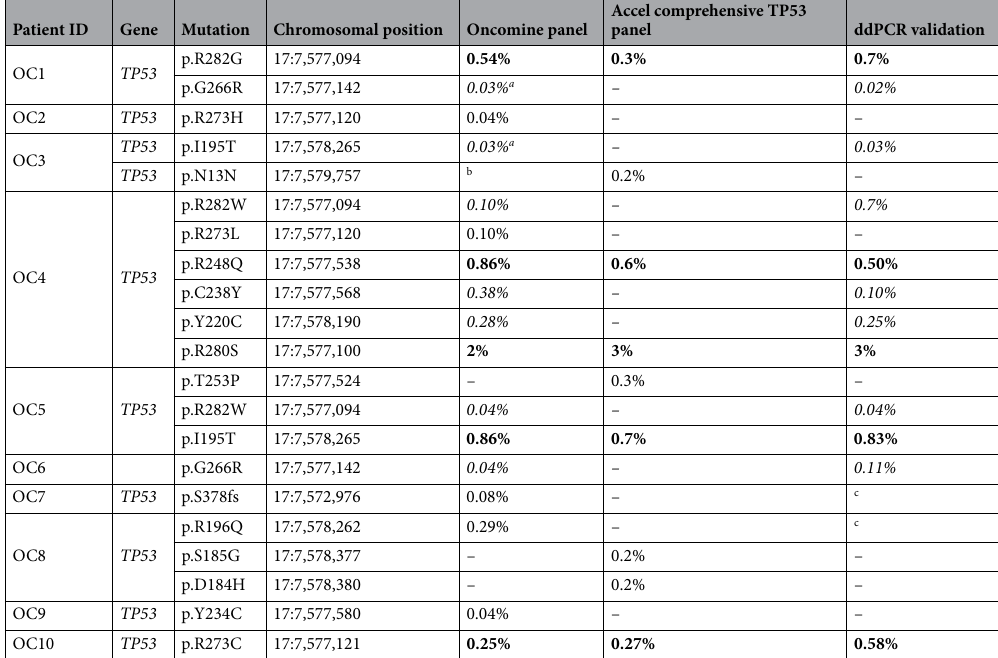
Table 1. Somatic mutations identified in ctDNA using the ONCOMINE and ACCEL NGS panels and validated by ddPCR. Bold denotes concordant variants identified using the Accel and Oncomine in cfDNA that were confirmed by ddPCR. Italics denotes variants found in Oncomine or Accell that are confirmed via orthogonal validation using ddPCR. a Below threshold. b Not covered. c Not tested. –, not